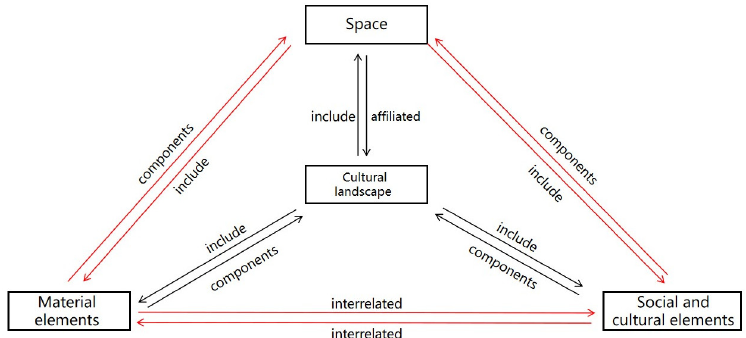
Figure 1. The connotation of cultural landscape (source: Drawn by the author).